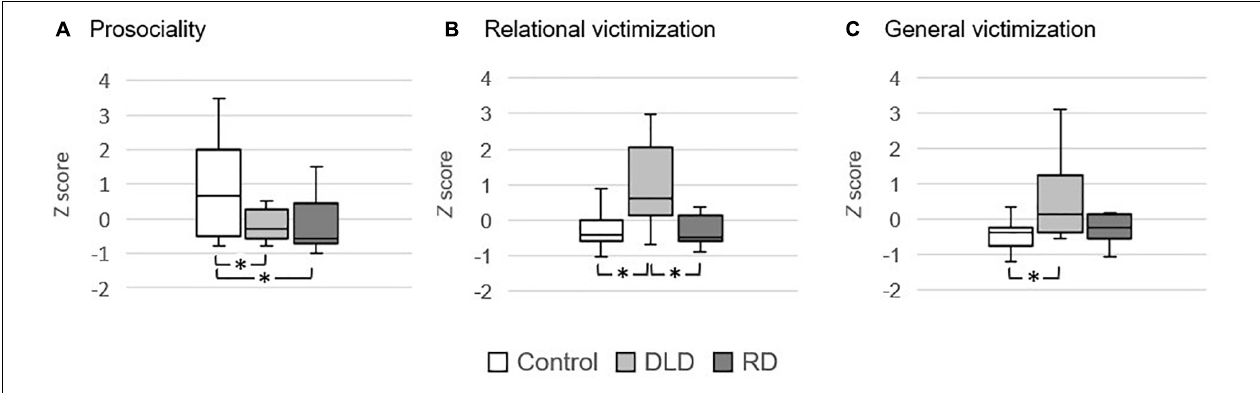
FIGURE 1 | Group boxplots representing the scores on the CESC for the (A) prosociality, (B) relational victimization, and (C) general victimization scores. All measures are expressed in Z-scores (0, 1). ∗ p <